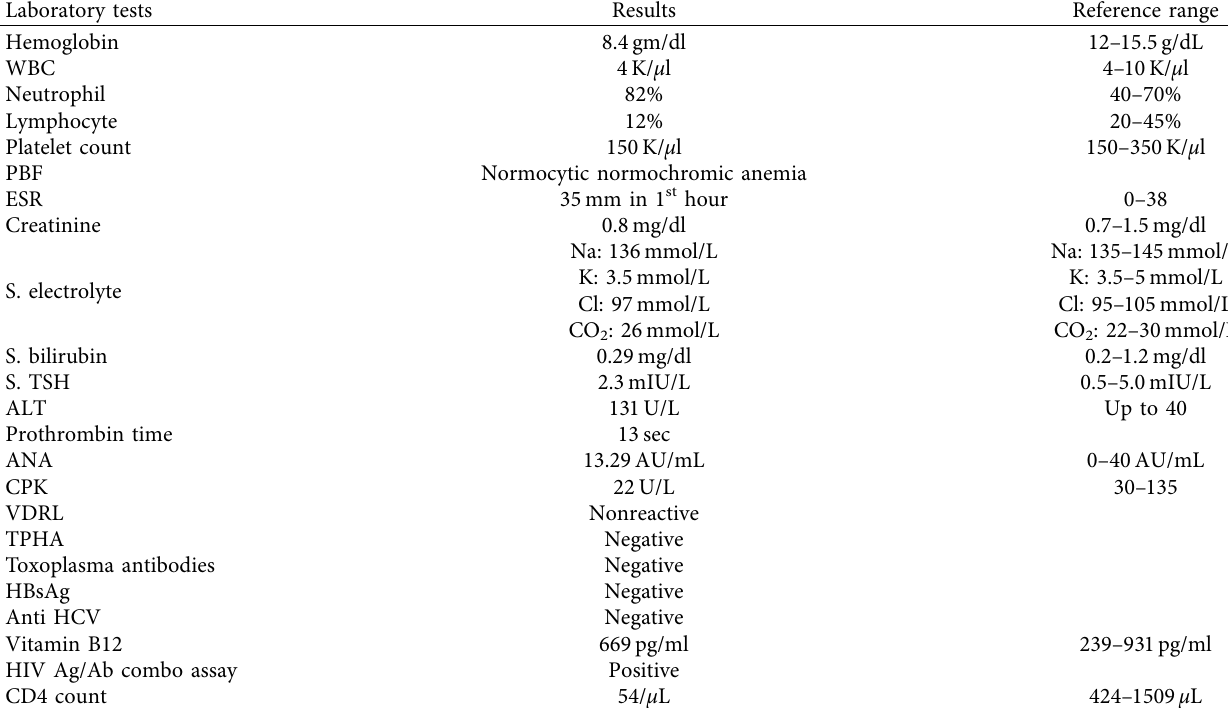
Table 1: Biochemical